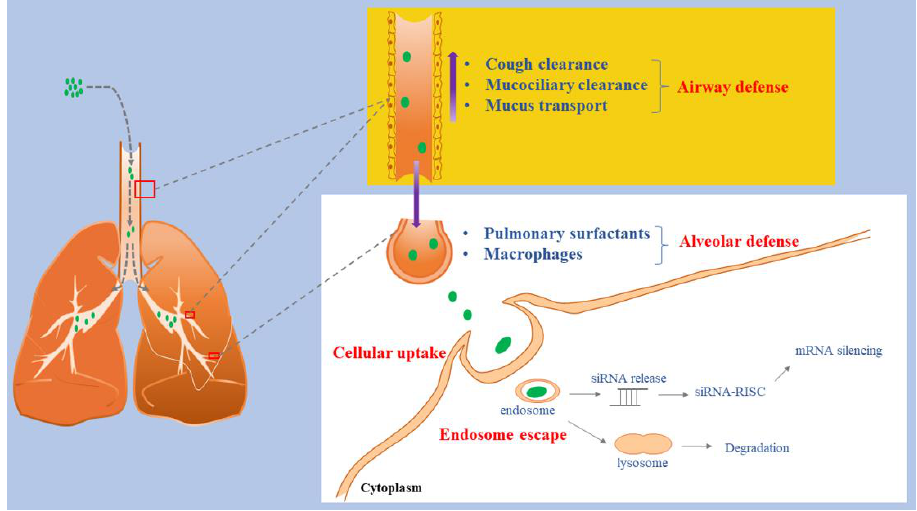
Figure 2. Schematic illustration of siRNA inhalations delivery barriers.